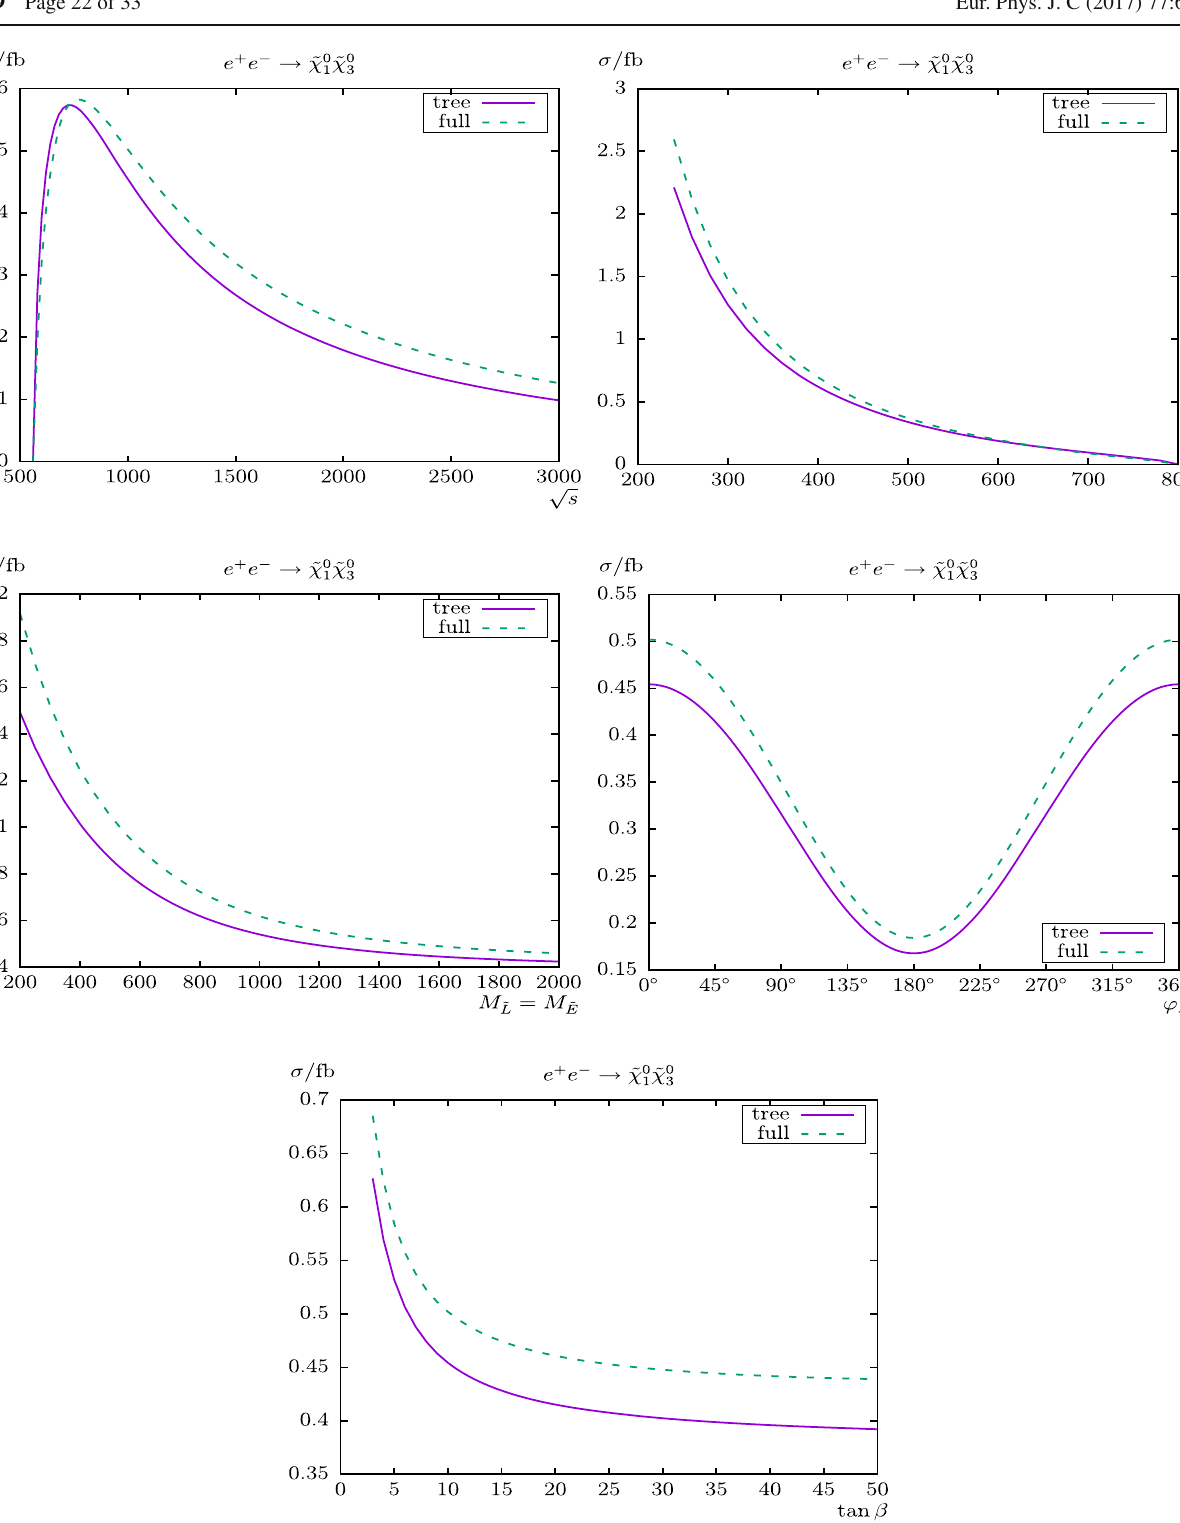
= M ˜ (left) and ϕ M (right) L E 1